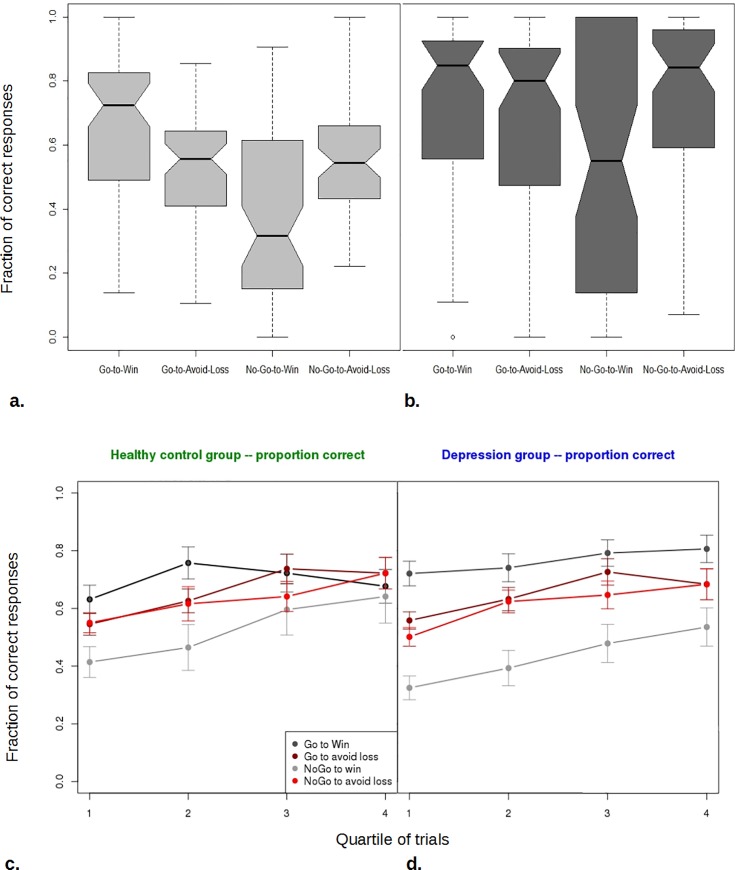
Behavior in the ‘discovery’ version of the task closely replicates previous results regarding the effect of trial valence on the propensity to act.a. Here, depressed and healthy groups are combined. Shaded bars: interquartile ranges; Notch: standard error of the median. During early trials participants perform much better in Go-to-Win than No-Go-to-Win, where they do worse than chance. b. Late trials, but otherwise as in a. All conditions show increased performance–each median has improved. However different abilities of participants to learn the optimal behavior results in greater spread of performance. This is particularly striking for the No-Go-to-Win condition. c. Performance in each quartile of trials for the Healthy Control group, showing learning across trials. Bars are +/- 1 standard error of the mean. d. As in c. but for the Depression group. Differences group differences between c. and d. are not significant.